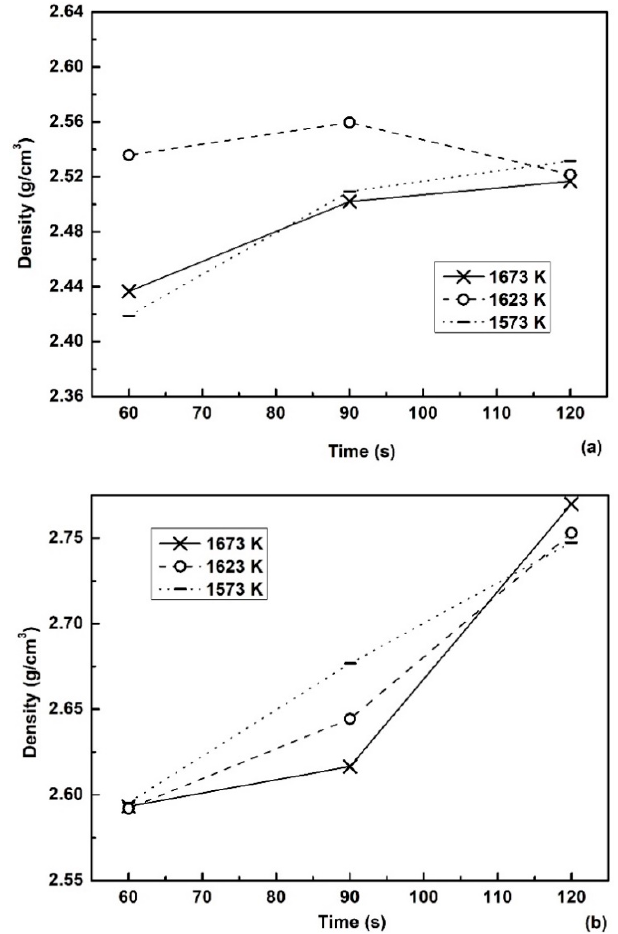
Figure 10. ( a ) Apparent densities and ( b ) true densities of slag films obtained at different slag bulk temperatures and probe immersion times.